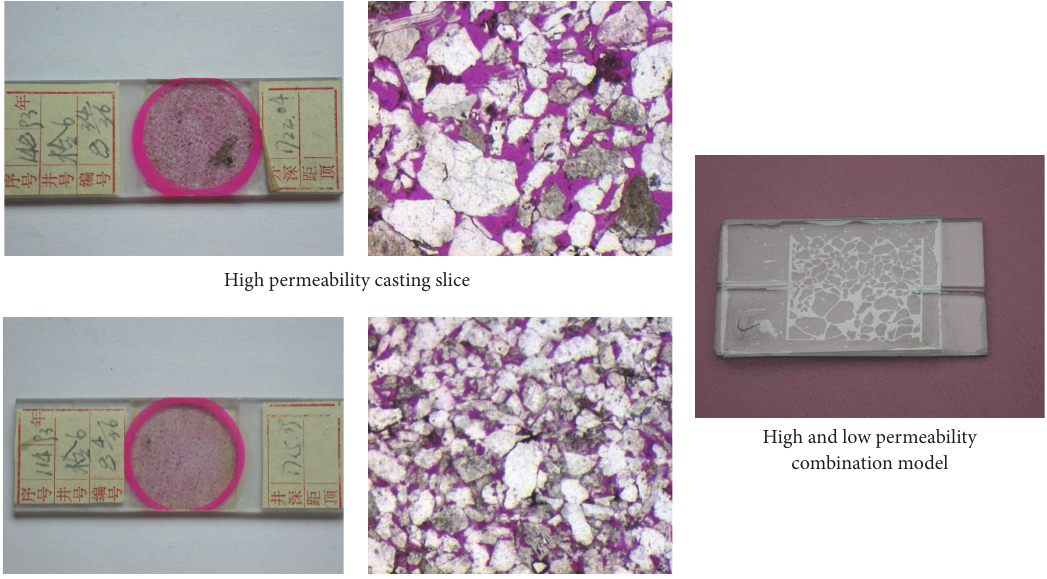
Figure 1: Microscopic plane visualization